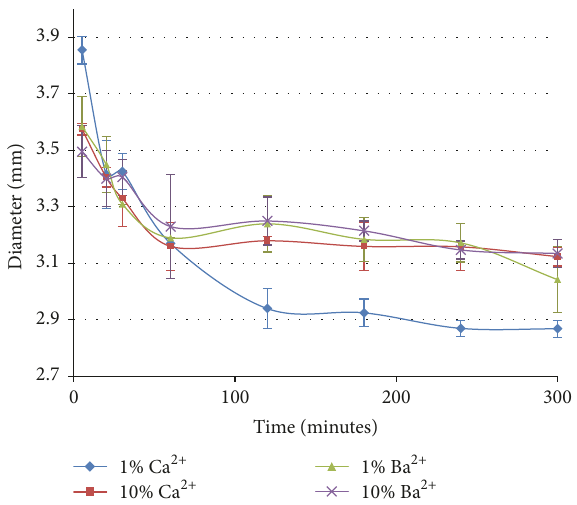
Figure 4: Diameters of alginate beads incubated in different concentrations of Ca 2+ and Ba 2+ at a low temperature (8 ∘ C) for various gelling times.